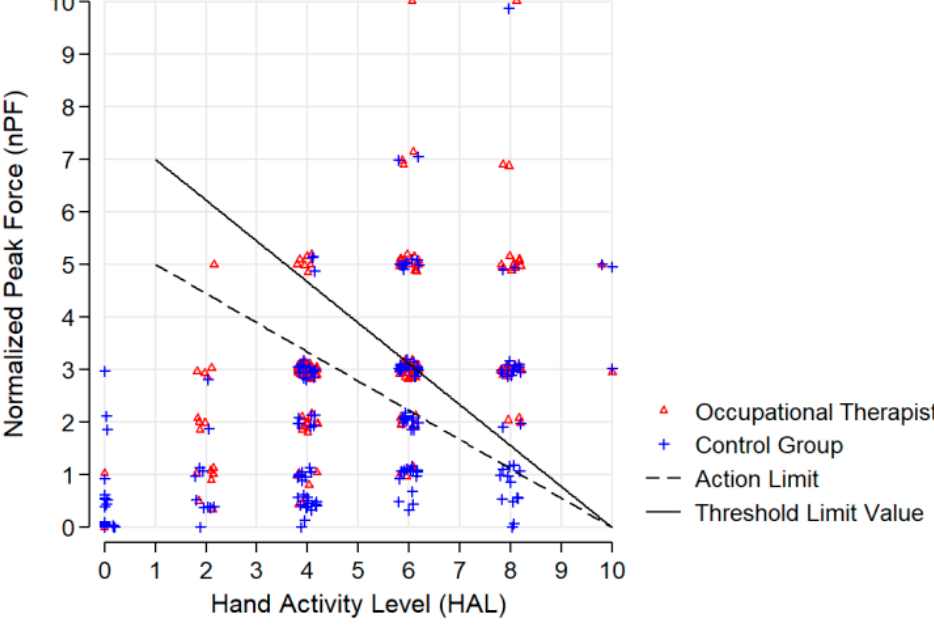
Figure 2. The hand activity level (HAL), normalized peak force (nPF), threshold limit value (TLV), and action limit (AL) of the study population.